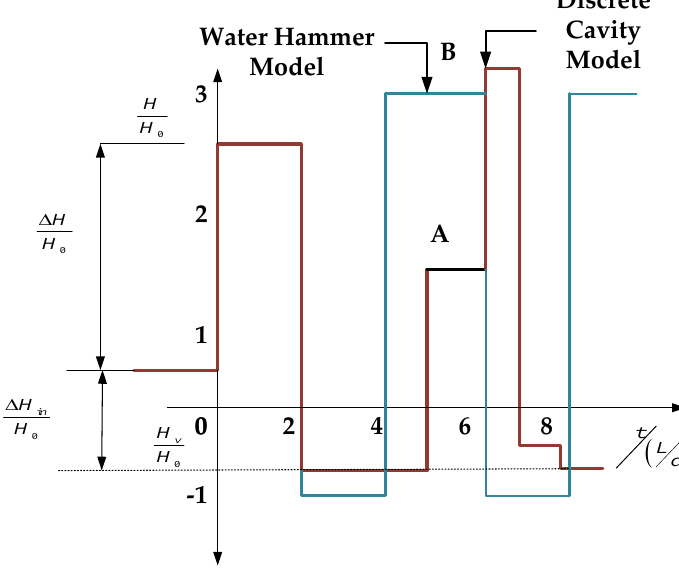
Figure 15. Discrete cavity model for column separation.